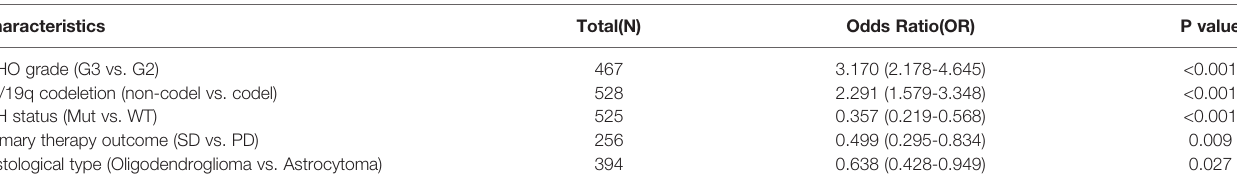
TABLE 2 | Correlation between NCAPG2 and clinic-pathological characteristics examined by logistic regression. Characteristics WHO grade (G3 vs.